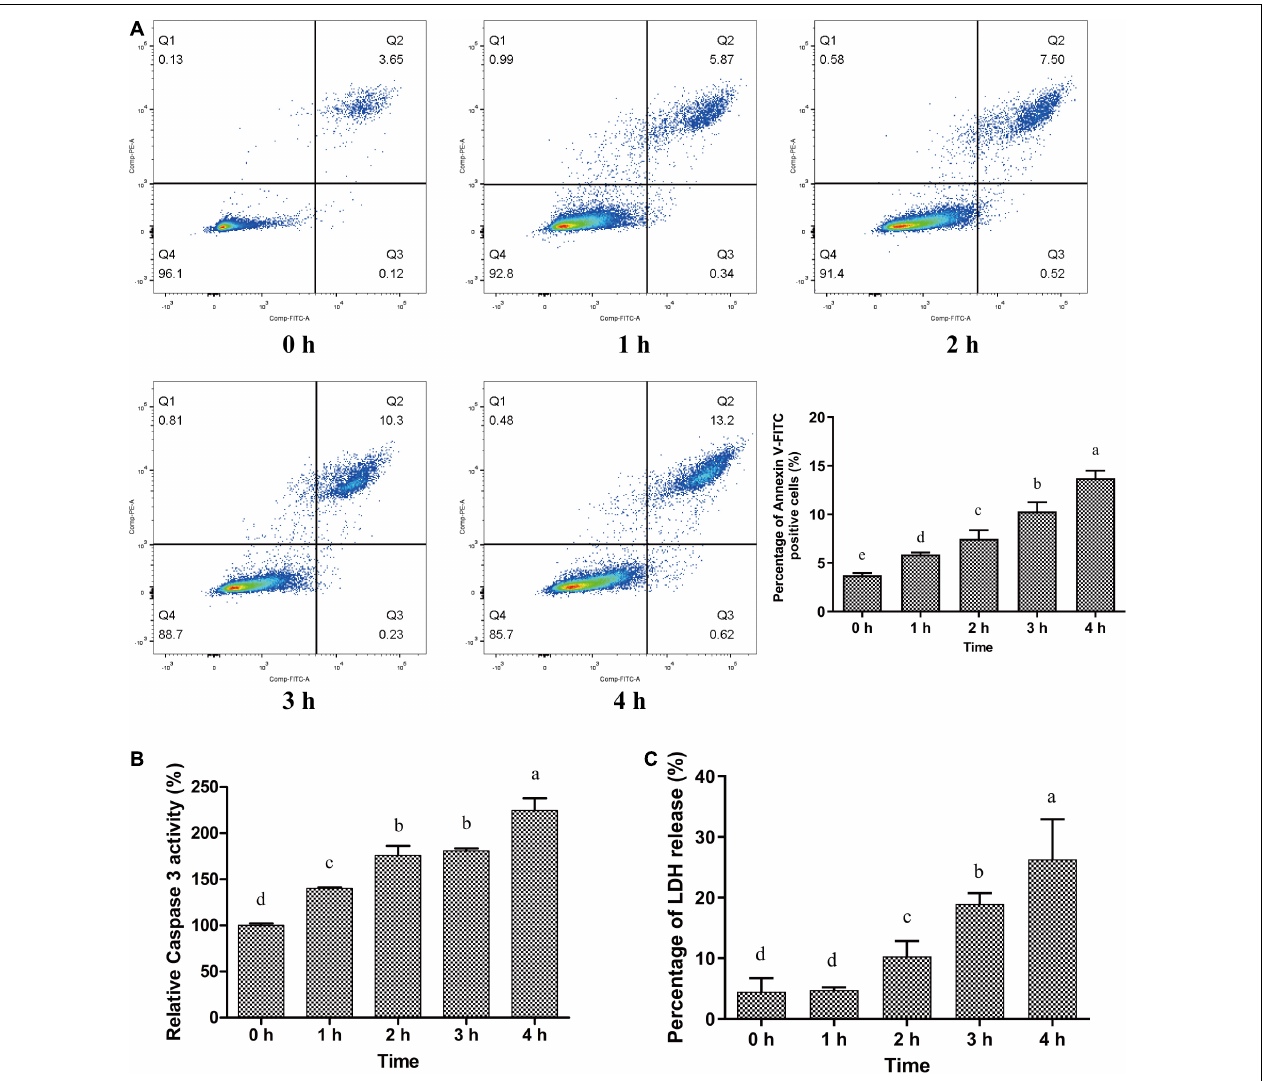
FIGURE 4 | Cytotoxic and apoptotic effect of C. sakazakii on HBMEC. (A) C. sakazakii -infected HBMEC were stained with Annexin V-FITC/PI and analyzed with a flow cytometer. (B) Caspase-3 activity in HBMEC after C. sakazakii infection for 0, 1, 2, 3, and 4 h. (C) Relative LDH release from C. sakazakii –infected HBMEC. Error bars represent the standard deviation ( n = 3), Mean values with different lower-case letters are statistically different from one another ( P <